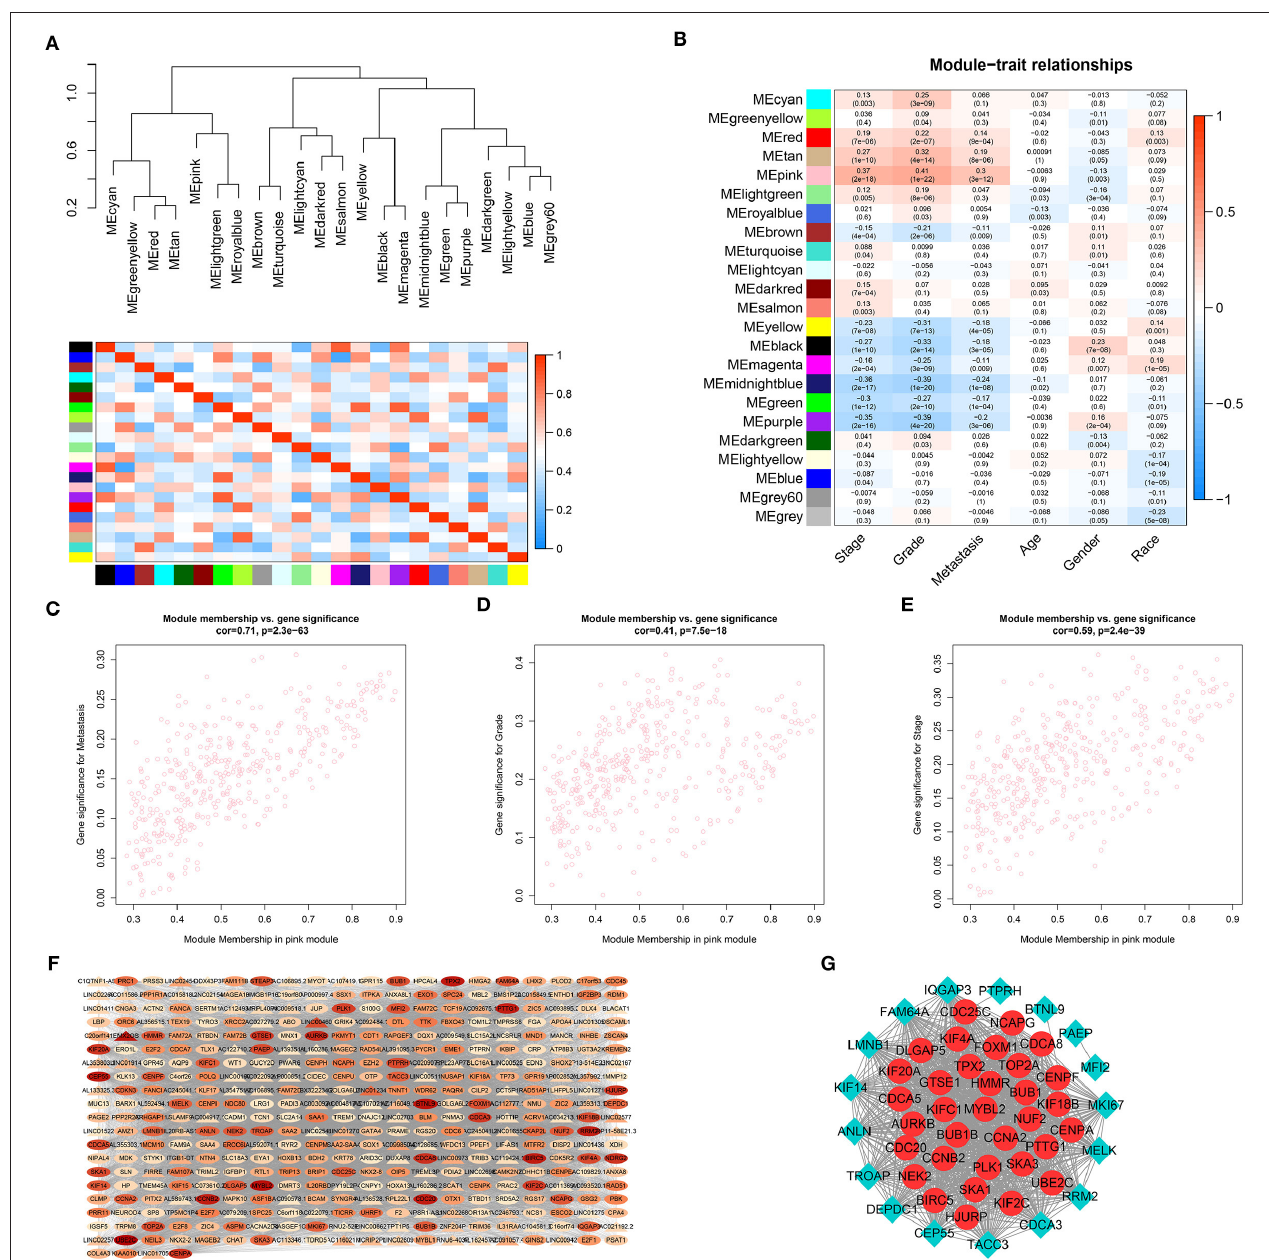
FIGURE 3 | Identification and validation of the distant metastasis-related module and PPI network construction. (A) Hierarchical clustering tree and heatmap plot of module eigengene. Each branch of the hierarchical clustering tree represents a module eigengene. Each row or column in the heatmap plot of topological overlap corresponds to one module eigengene labeled by a distinct color. In the heatmap, blue represents negative correlation, while red represents positive correlation. (B) Heatmap of module-trait correlation. Each row represents a co-expressed module and each column indicates a clinical trait. Each cell contains Pearson’s correlation between a co-expressed module and a clinical feature and the corresponding p value is in bracket. Scatterplots of GS for distant metastasis (C) , histologic grade (D) and pathological stage (E) vs. MM in pink module. (F) WGCNA co-expression network of pink module. Triangle represents lncRNA and oval stands for other genes. The color of the nodes from white to red indicates the degree of gene connectivity from low to high. (G) PPI network of WGCNA hub genes. The red node represents the hub mRNA in the network and the blue diamond stands for non-hub mRNAs in the network. The value of p < 0.05 is considered statistically significant. GS, gene significance; MM, module membership; WGCNA, weighted gene correlation network analysis; PPI, protein–protein